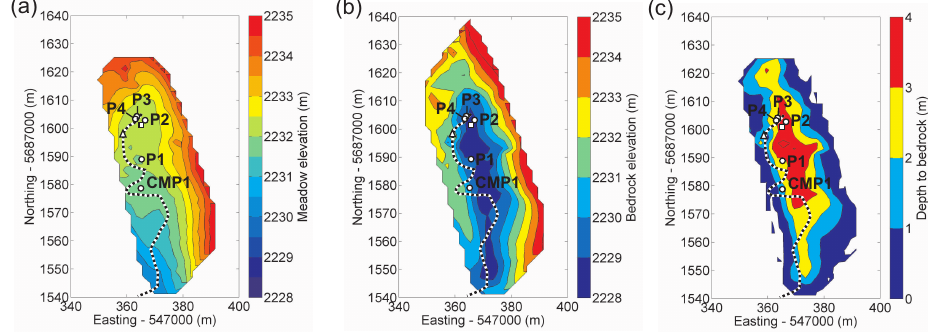
Fig. 9. Contoured maps of (a) meadow topography from 2-m LIDAR DEM, (b) subsurface bedrock topography produced by interpolating bedrock picks made on ERT and GPR profiles, and (c) depth to bedrock produced by differencing (a) and (b). Dotted line – surface stream channel; circles – piezometers P1-P4 and the center of the CMP1 GPR profile; triangle – monitoring weir; square – excavated soil pit.